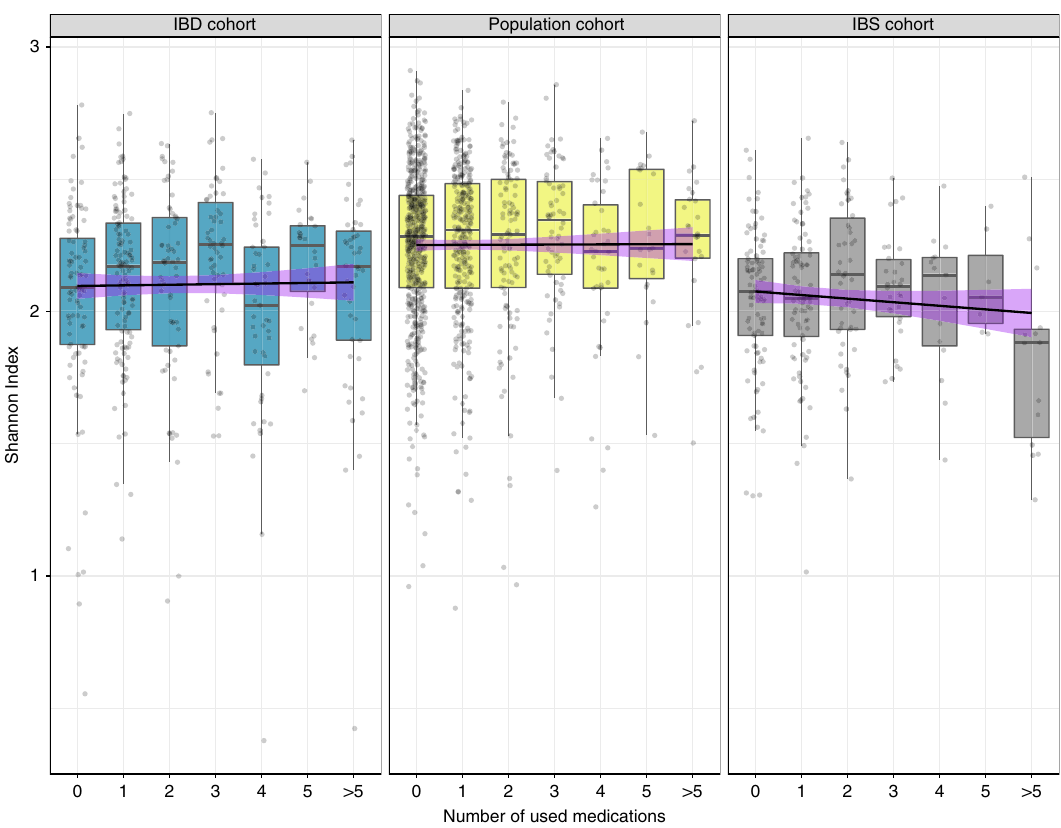
Fig. 1 Microbial richness (Shannon index) for each participant strati fi ed per number of medications used. Dots represent the richness value per each sample in the study. Boxplot shows the median and interquartile range (25th and 75th). Whiskers show the 1.5*IQR range. Black lines show linear regression with a purple shadow indicating the 95% con fi dence interval. From left to right, the IBD cohort ( N = 454 samples, linear regression, coef fi cient = − 0,001, p = 0.88), population cohort ( N = 1124 samples, linear regression, coef fi cient = − 0.002, p = 0.77) and the IBS cohort ( N = 305 samples, linear regression, coef fi cient = − 0.016, p = 0.06). (Source data are provided as a Source Data fi